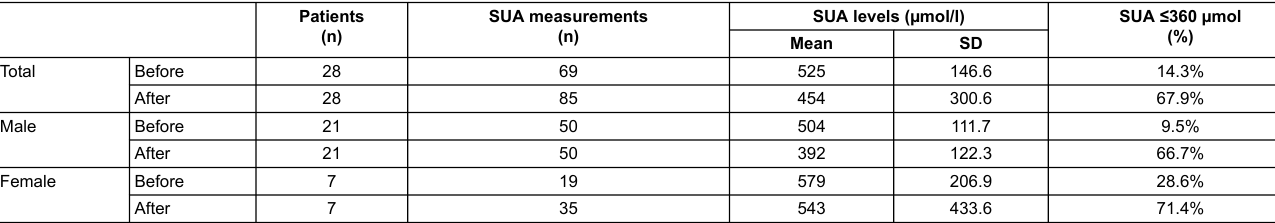
Table 3: Treatment effect of